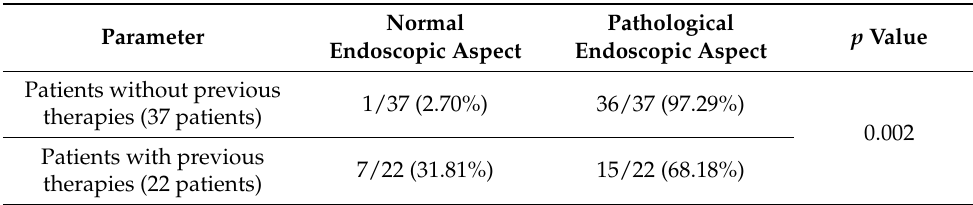
Table 1. Demographic and clinical characteristics of the patients. Table 2. Correlation between endoscopic aspect and previous H. pylori eradication